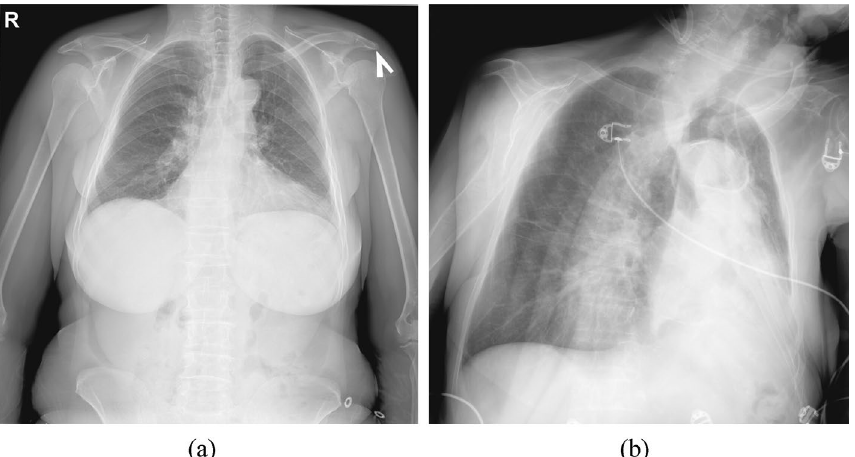
Figure 3. ( a ) A chest X-ray example, where the inclusion of gender prediction head of the framework corrected a false-positive disease prediction. ( b ) A chest X-ray example mis-classified as defected, i.e. not representing a fronal chest X-ray.